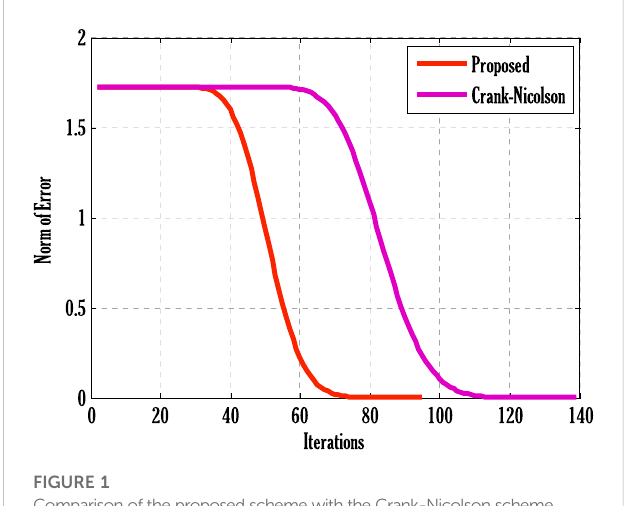
FIGURE 1 Comparison of the proposed scheme with the Crank-Nicolson scheme for the norm of error over iterations using N t (cid:2) 190 , N x (cid:2) 45 , t f (cid:2) 1 , L (cid:2) π .